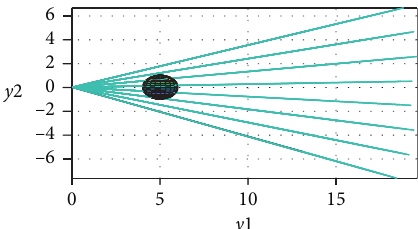
Figure 9: Vertical projection of the 3D lidar’s view for three obstacles in 5m.